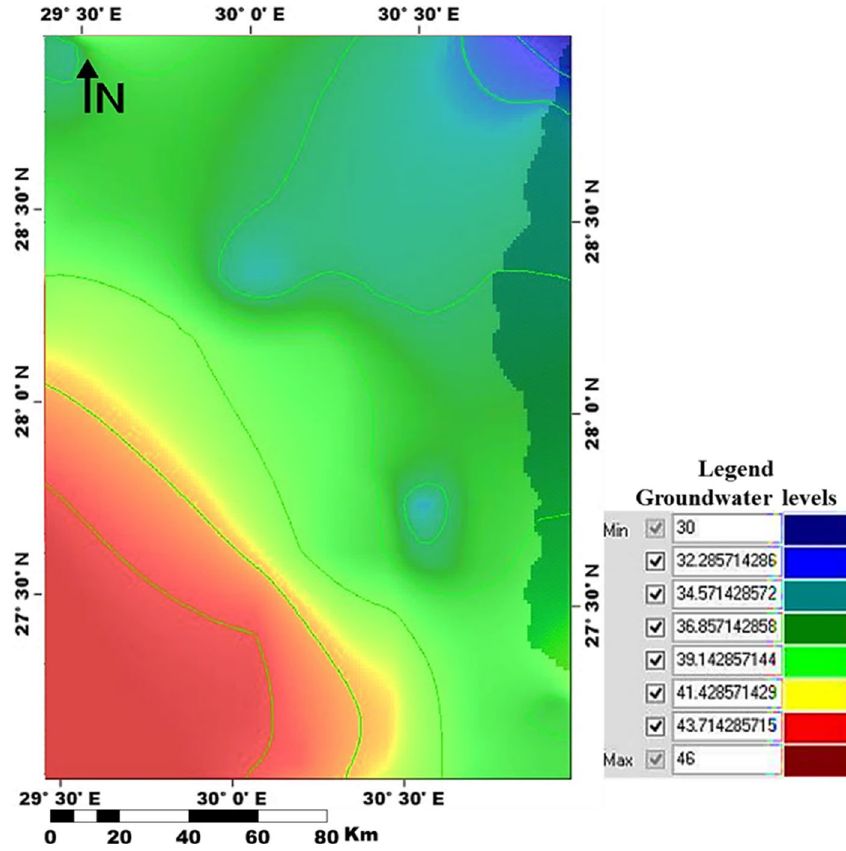
Fig. 10 Initial distribution head in the modeled